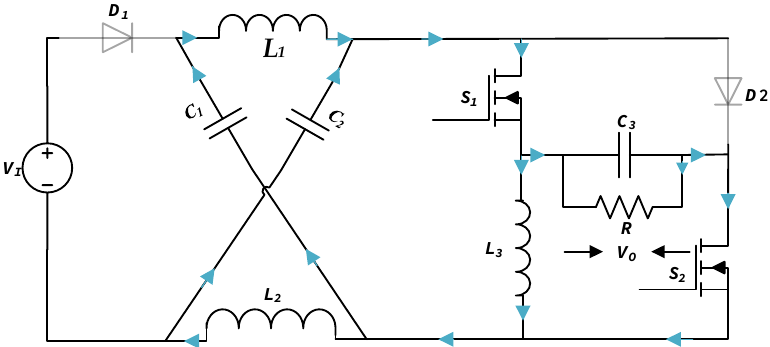
Figure 4. The configuration of the proposed HS-SZC during operating in Mode 1.